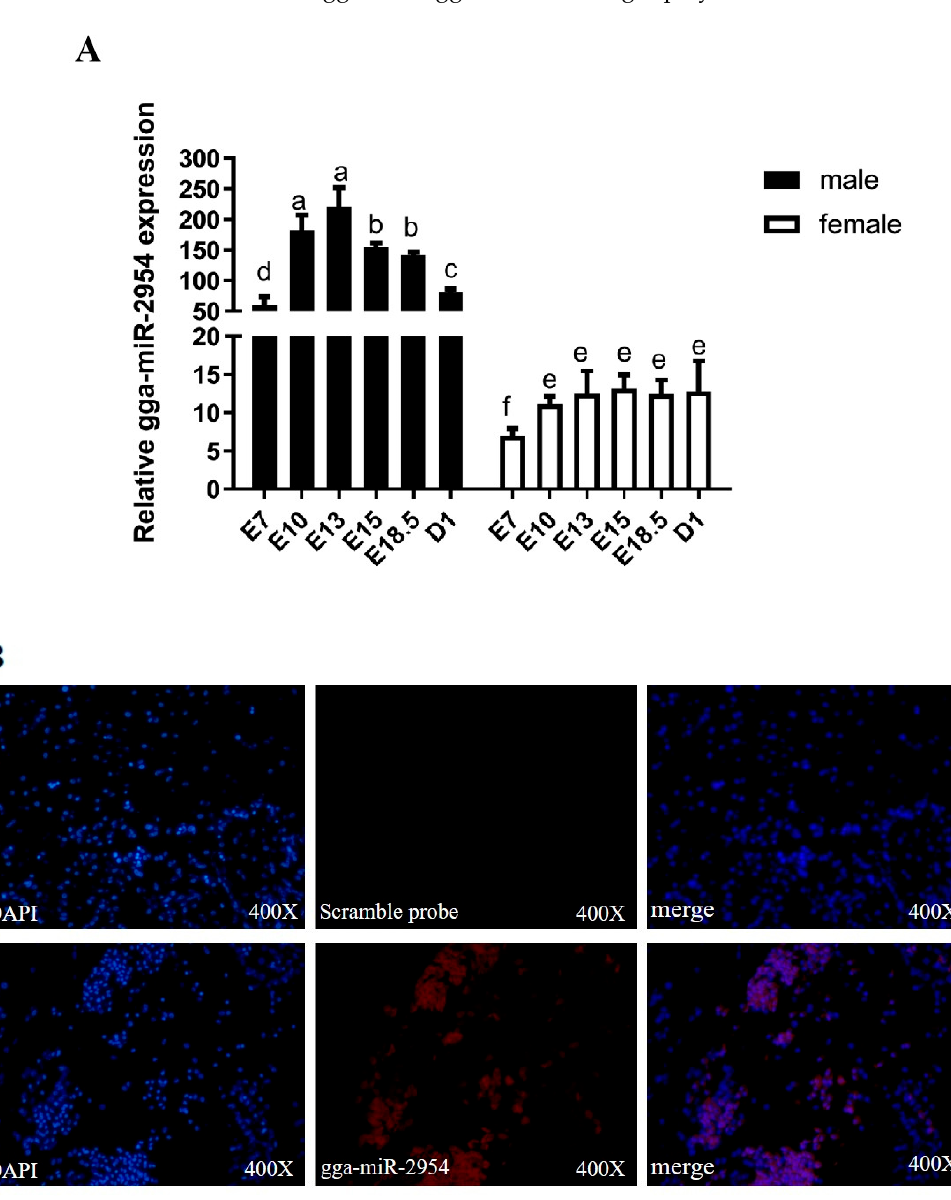
Figure 1. The expression of gga ‐ miR ‐ 2954 during the development of chicken embryonic skeletal muscle. ( A ) Gga ‐ miR ‐ 2954 expression in chicken embryonic leg muscle between sexes from E7 ‐ D1 stages. Bars with different superscripts are significantly different ( P < 0.05). ( B ) Fluorescence in situ hybridization result of gga ‐ miR ‐ 2954 in male leg muscle at E13.5, red staining indicates gga ‐ miR ‐ 2954 ‐ positive hybridization signals.